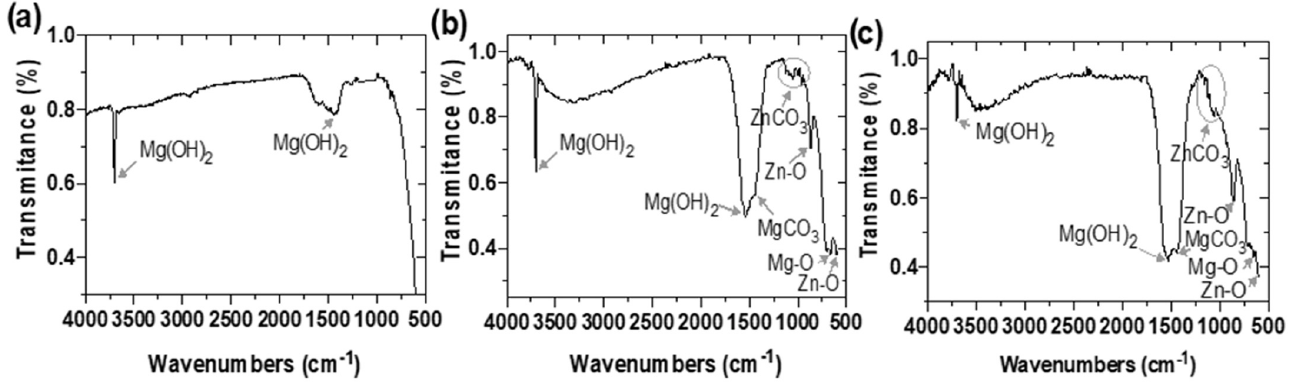
Figure 6. FTIR spectra of ( a ) Mg-Ca0.3 surface and electroless ZnO deposits, obtained from aqueous solutions (10 − 3 M, at 21 °C) of ( b ) ZnO and ( c ) Zn(NO 3 ) 2 .